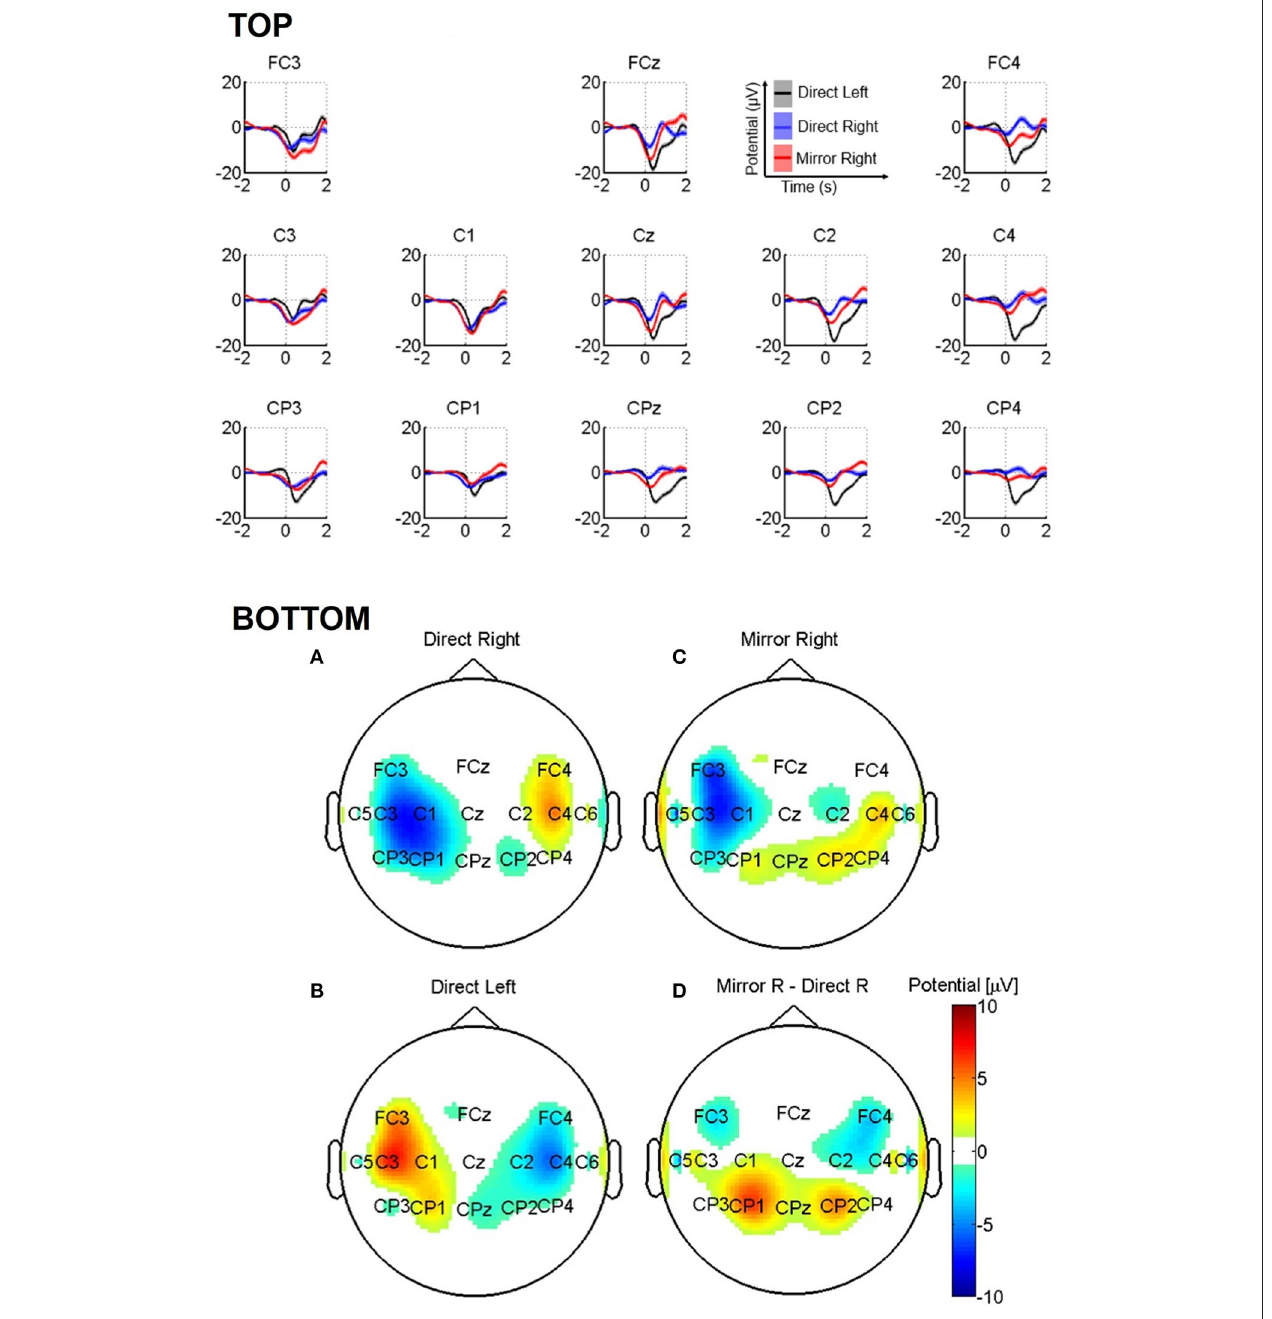
FIGURE 3 | (Top) Grand-average MRCPs of healthy participants for direct left , direct right , and mirror right conditions. The shaded area represents standard error of the mean (SEM) computed separately for each condition. (Bottom) Topographic images for (A) direct right , (B) mirror right , (C) direct left , and (D) the difference between mirror right and direct right